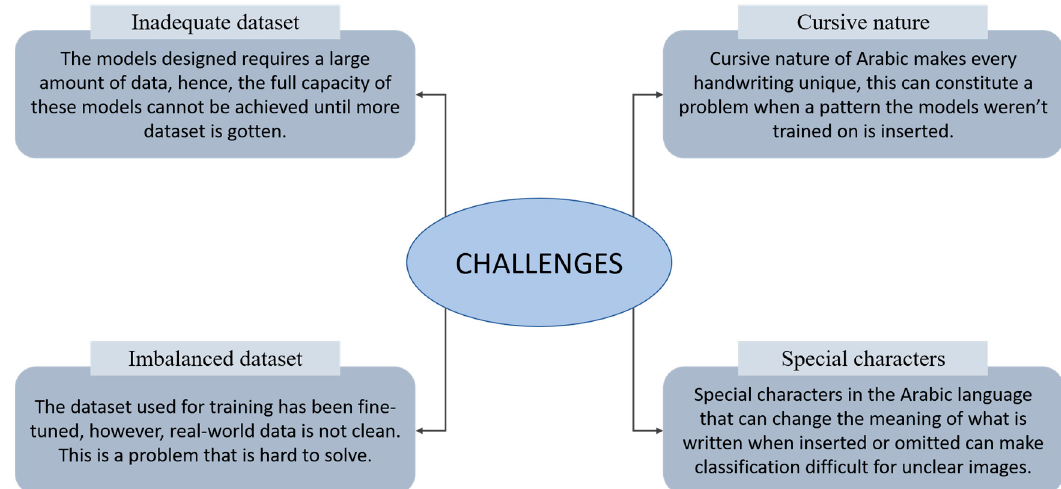
Figure 11. Challenges and open